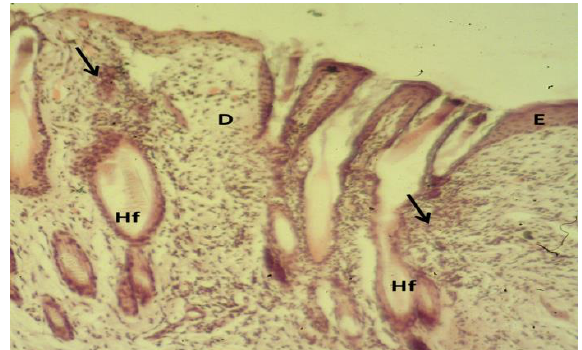
Figure, 16: Magnified section of skin (21 days-control) shows epidermis (E) and dermis (D), hair follicle (Hf) and aggregation of inflammatory cells (arrow) H and E, 100 x.